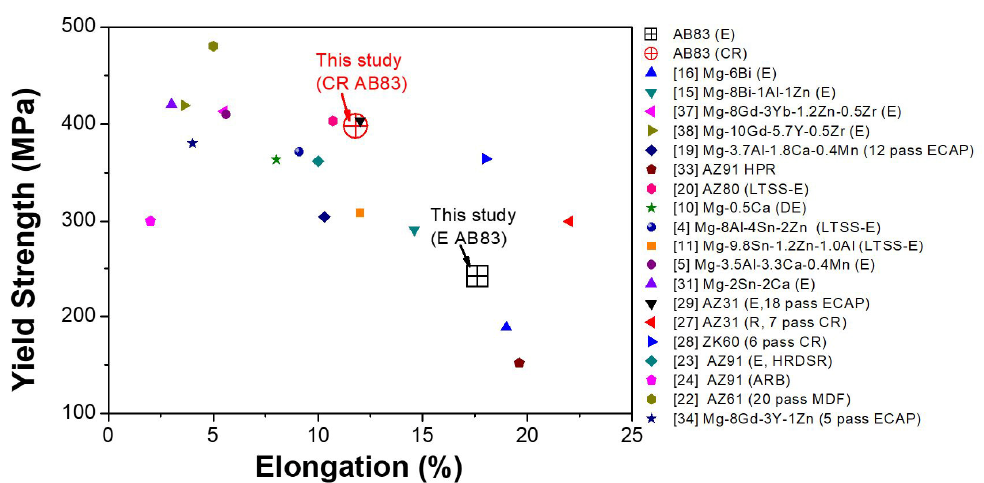
Figure 9. Comparison of UTS vs. EL of CRed AB83 with those of previously reported wrought Mg alloys [4,5,10,11,15,16,19,20,22–24,27–29,31,33,34,37,38] (E: extrusion; CR: caliber rolling; ECAP: equal channel angular pressing; HPR: hard-plate rolling; LTSS–E: low-temperature slow-speed extrusion; DE: double extrusion; HRDSR: high-ratio differential speed rolling; ARB: accumulative roll bonding; MDF: multidirectional forging).